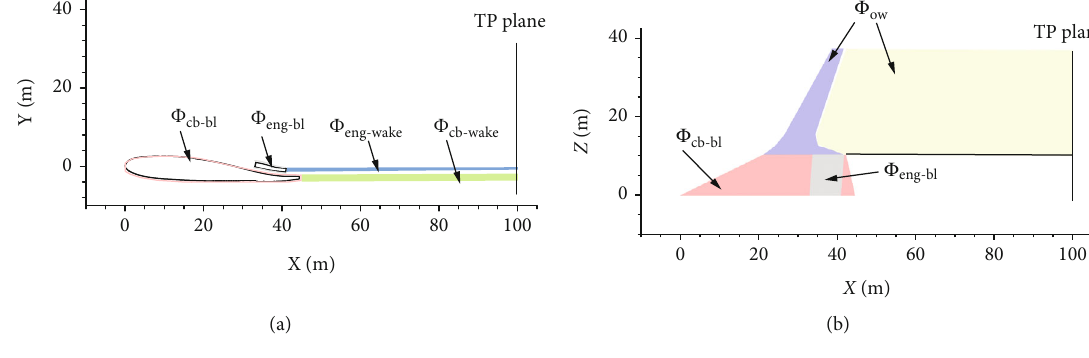
, Φ , Φ , Φ , and Φ cb ‐ bl ow eng ‐ bl cb ‐ wake eng ‐ wake